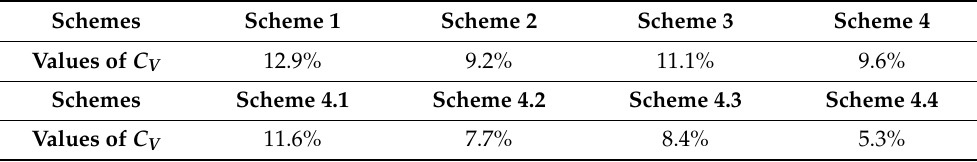
Table 4. Summary of C V values of the ammonia mass concentration field distribution in the upstream section of the catalyst inlet corresponding to the different